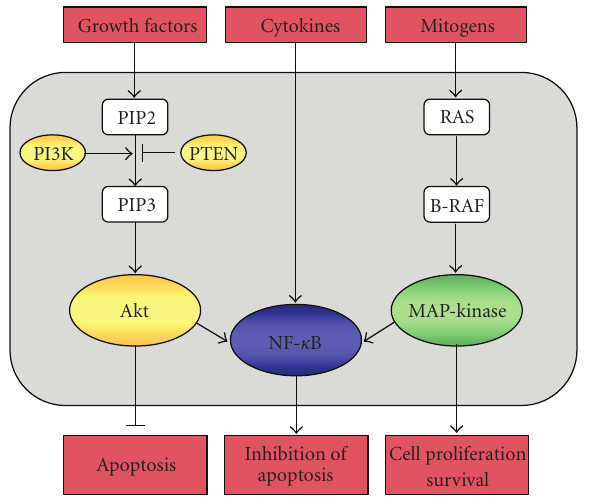
Figure 1: Activating pathways known to be constitutively active and contributing to the chemoresistance of melanoma cells. Over 60% of melanomas have activating mutations of B-RAF, 30% have lost PTEN expression, majority with NF- κ B